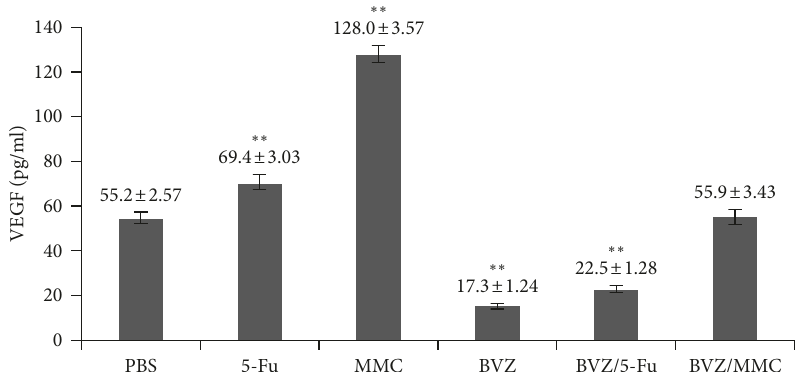
Figure 2: Effects of bevacizumab (BVZ), mitomycin C (MMC), 5-fluorouracil (5-Fu), MMC+BVZ, and 5-Fu+BVZ on vascular endothelial growth factor (VEGF) levels in retinal pigment endothelium (RPE) cells.